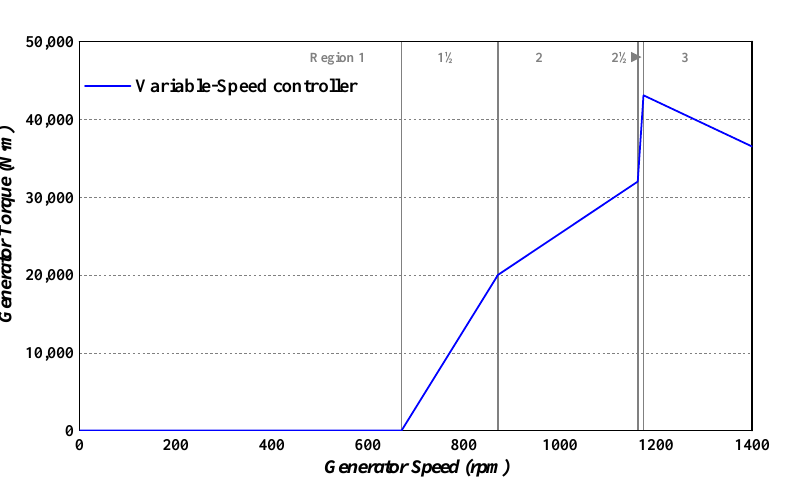
Figure 1. Torque-versus-speed response of the variable-speed